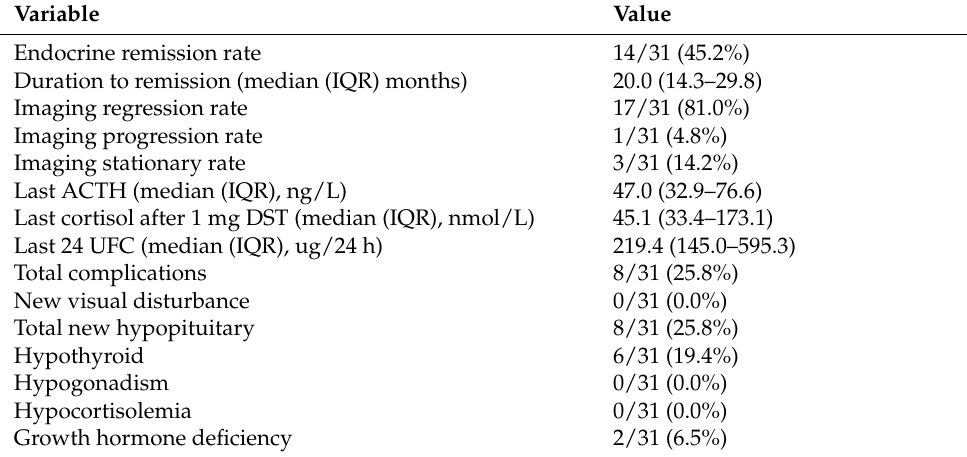
Table 2. Treatment outcomes of 31 patients with Cushing’s disease who underwent